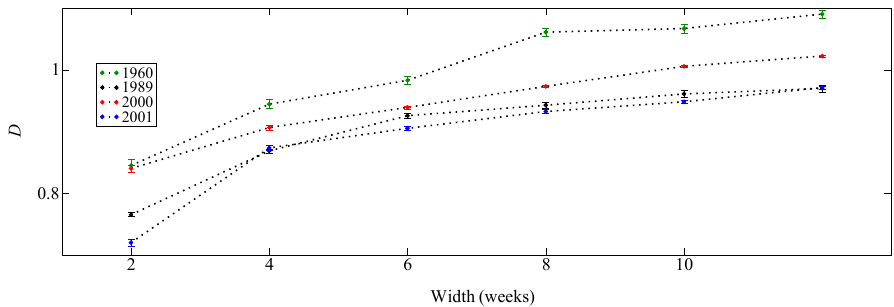
Figure 4. Box-counting dimension D for a storm state, as a function of window width. Lines correspond to storms on 1 April 1960, 13 March